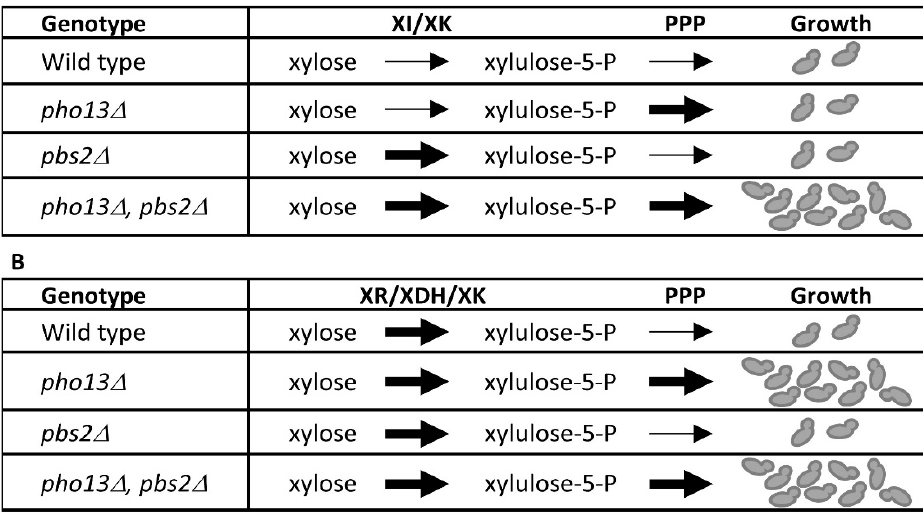
Figure 8. Proposed model showing involvement of PBS2 and PHO13 in xylose metabolism. ( A ) Cells expressing the XI/XK pathway (CEN.PK2-1C cells overexpressing P. ruminicola XI and XK) are limited in conversion of xylose to xylulose-5-P and require deletion of both PBS2 and PHO13 for improved xylose utilization. ( B ) Cells expressing the XR/XDH pathway (CEN.PK2-1C cells overexpressing S. stipitis XR and XDH with S. cerevisiae XK) are not as limited in xylulose-5-P production and show improved xylose utilization in strains with only the PHO13